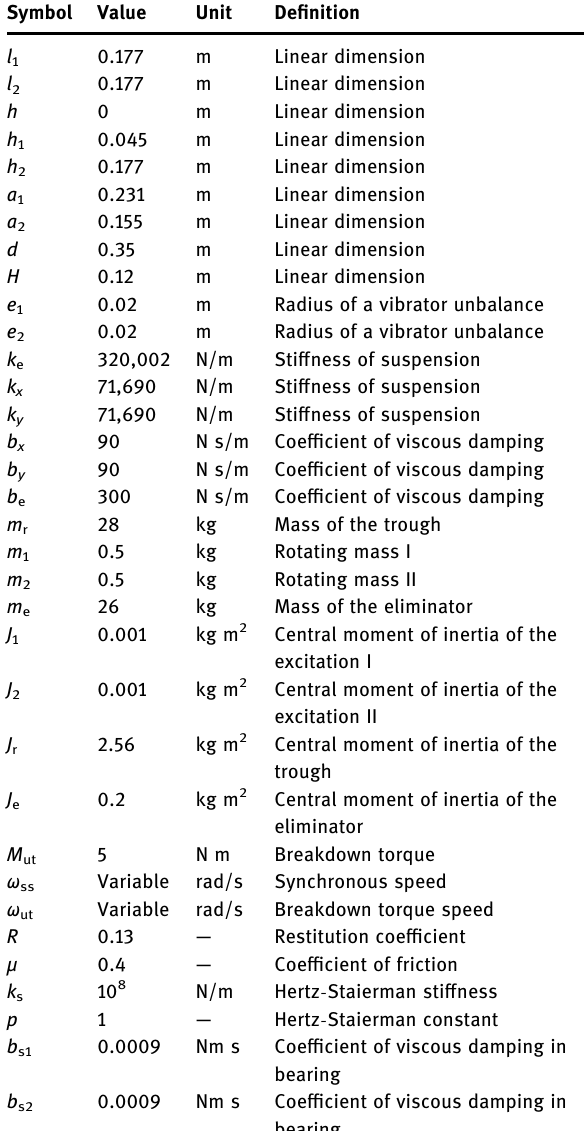
Table 1: Parameters of the simulated system